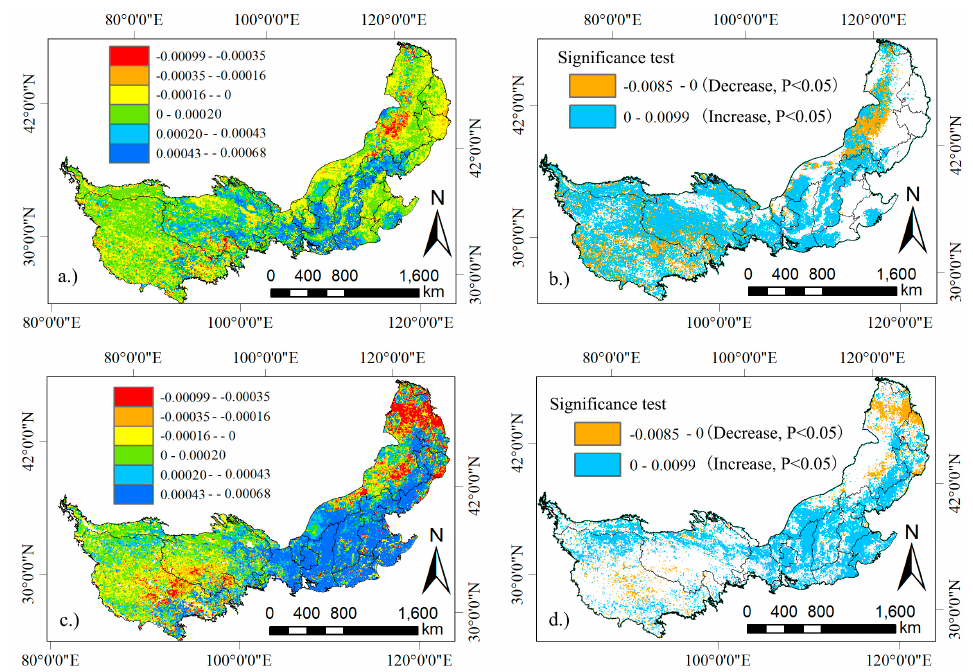
Figure 8. Sen’s slope and Mann–Kendall (M–K) significance test of NDVI under the impacts of climate change ( a , b ) and human activities ( c , d ).